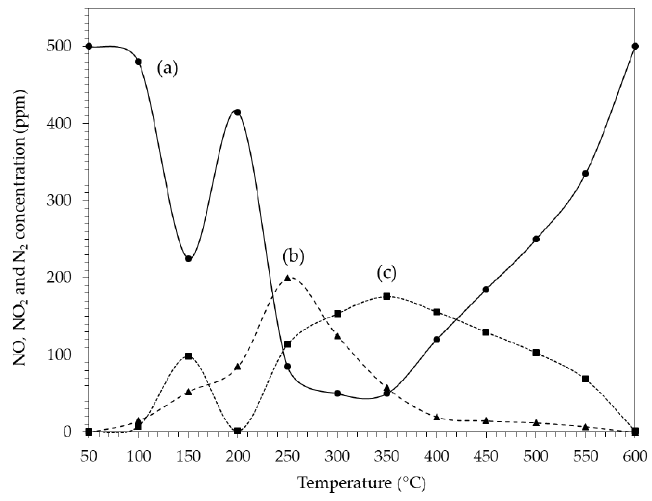
Figure 12. Composition of ( a ) NO; ( b ) NO 2 and ( c ) N 2 (calculated) in the microreactor as a function of temperature during the C 3 H 8 –SCR–NO with the catalyst 0.1PtAg / AW in the presence of H 2 . Inlet gas composition: 500 ppm NO, 625 ppm C 3 H 8 , 200 ppm CO, 660 ppm H 2 , 2vol.% O 2 , N 2 balance; GHSV = 128,000 h − 1 .